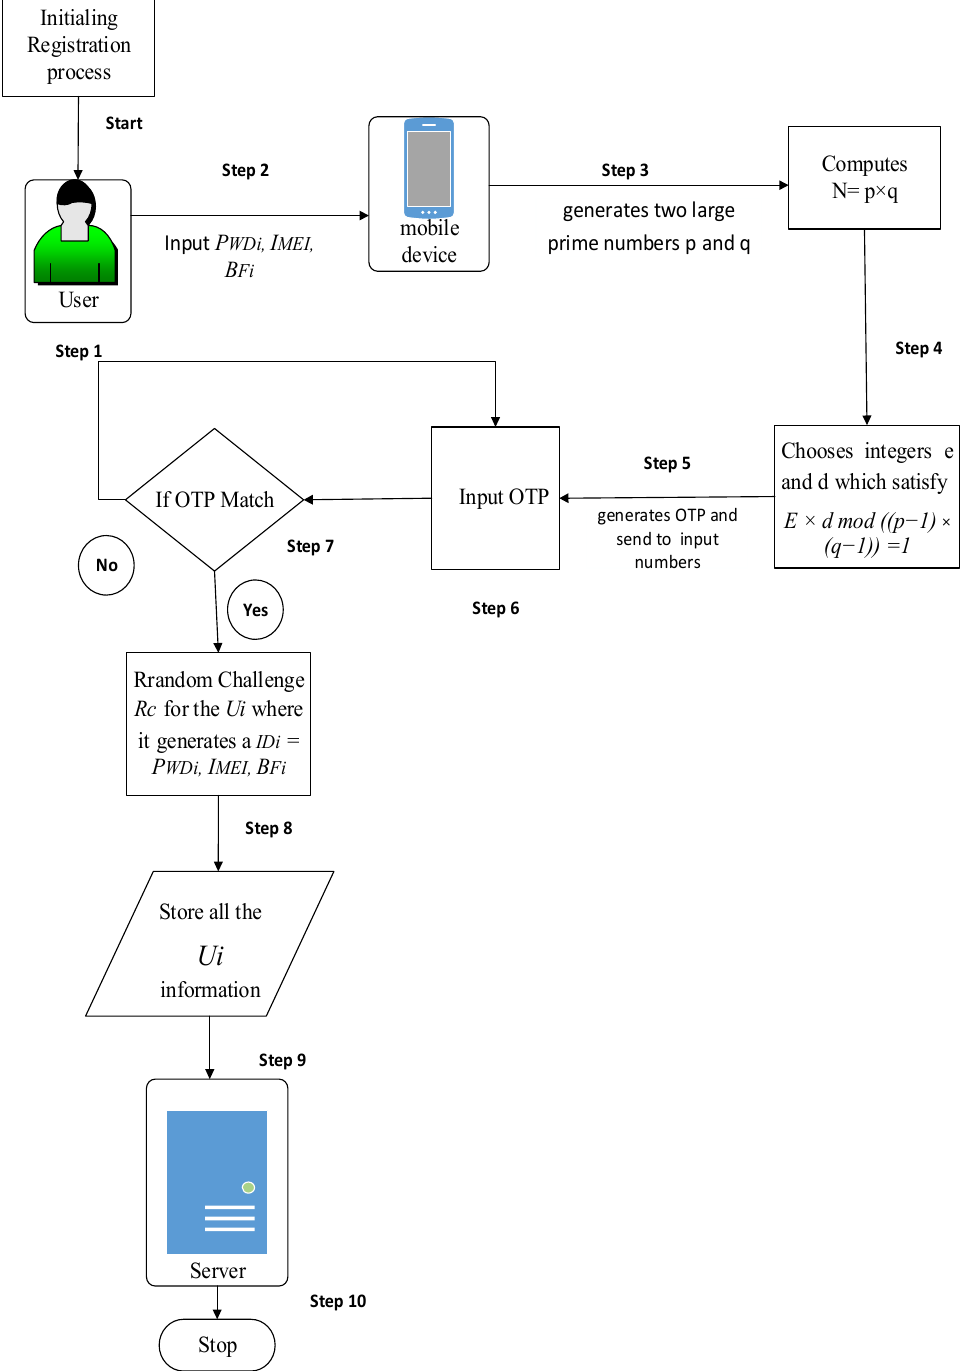
Figure 2. Registration process flow.